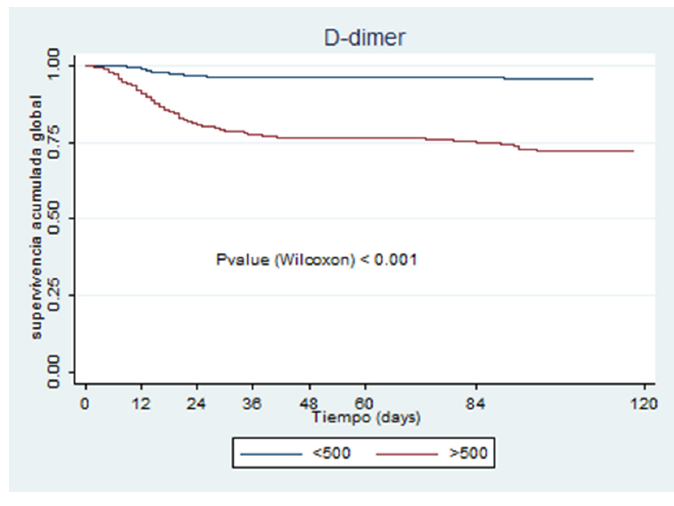
Figure 6. D-dimer.